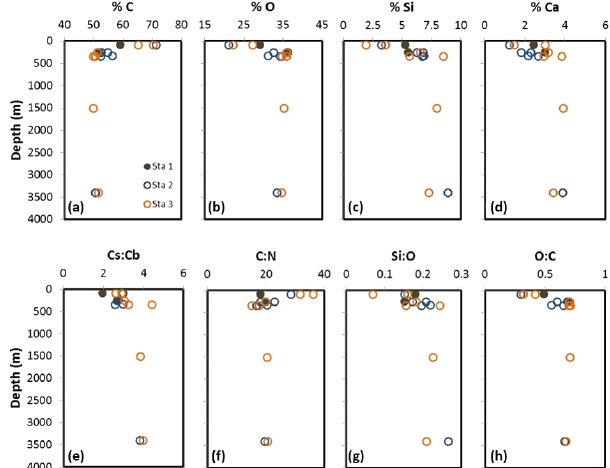
Figure 4. Atom percentages of different elements identified by XPS on the surfaces of the sinking particles: (a) carbon, (b) oxygen, (c) silicon, and (d) calcium. (e) Weight percentage ratio of carbon on the surface of the particles to bulk carbon measured by elemental analysis, (f) atomic C:N ratio of carbon and nitrogen at the surface, and (g) atomic silica:oxygen ratio, (h) atomic oxygen:carbon ratio. (Color scheme for symbols same as in Fig.